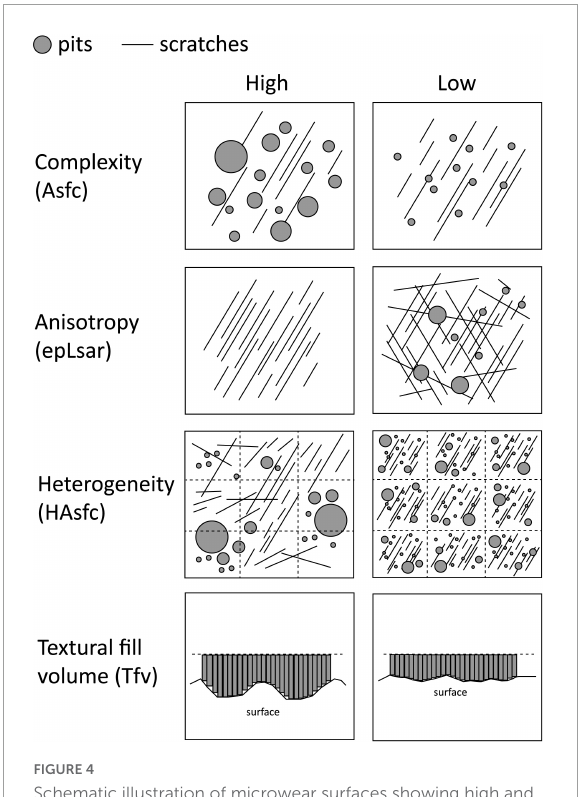
FIGURE4 Schematic illustration of microwear surfaces showing high and low values for four variables including complex textures, anisotropic textures, heterogeneous textures, and textural fill volume [modified from Scott et al. (2006) and Merceron et al.